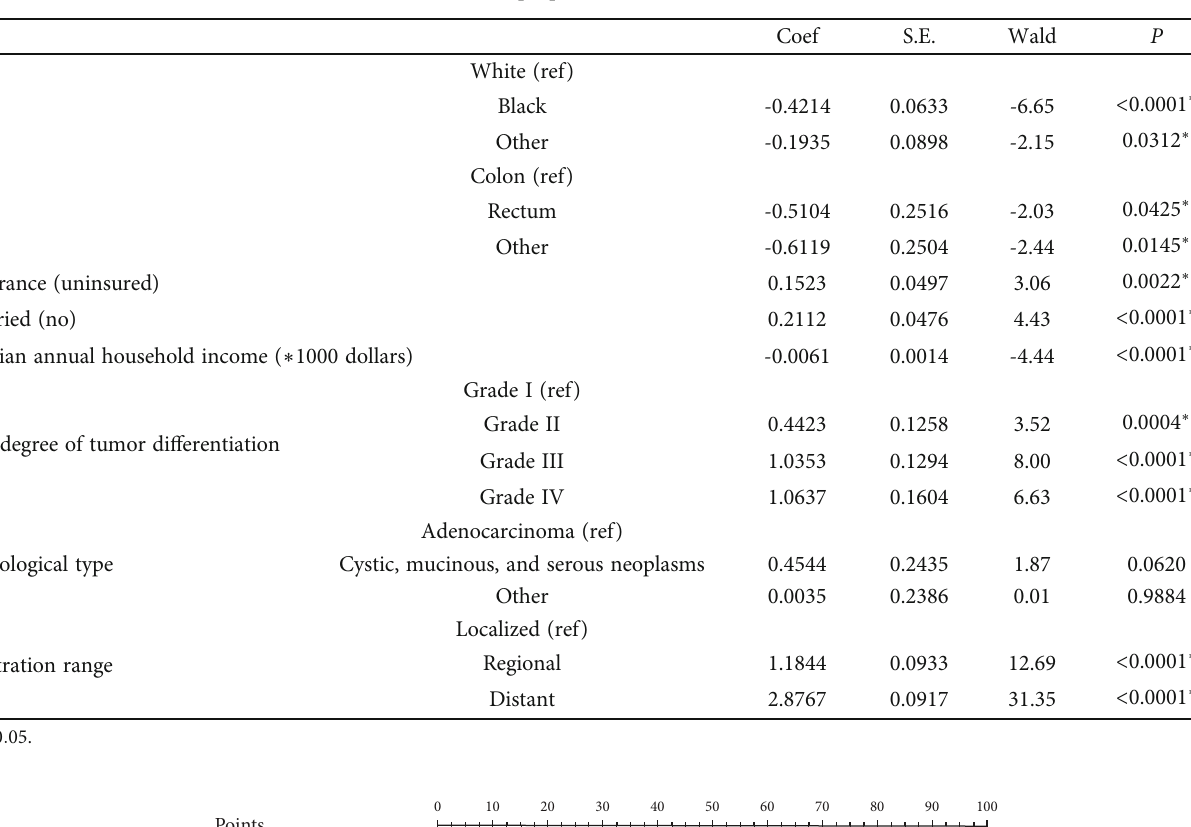
Table 3: Cox proportional hazard model.